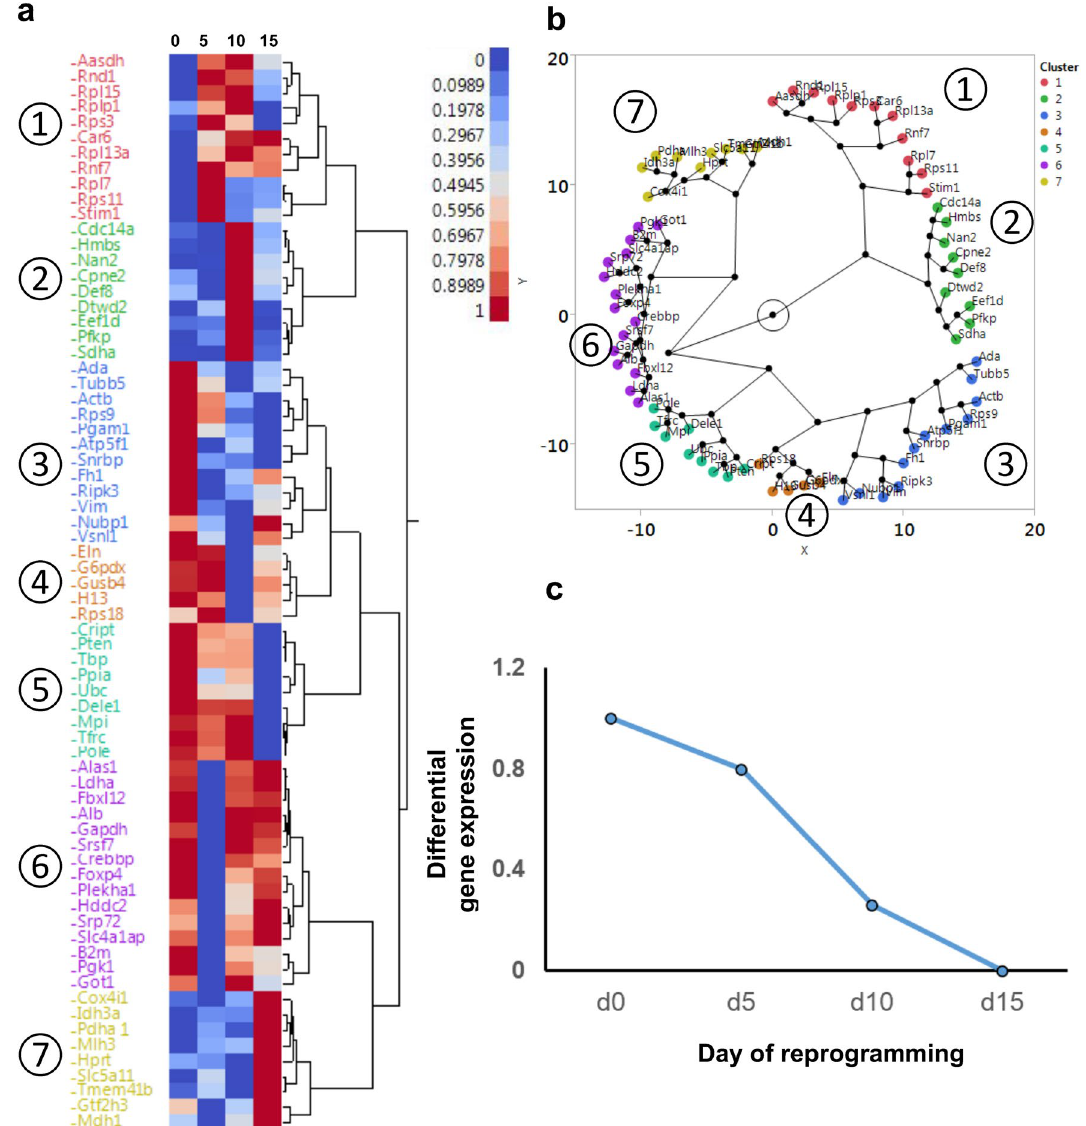
Figure 2. Expression change of 70 housekeeping genes throughout the iPS reprogramming process. (a) Clustering analysis of the dynamics of gene expression levels during reprogramming. Gene expression levels relative to Day 0 were considered and scaled from 0 to 1 for each gene. The color scale attributes red to a value of 1, indicating the highest gene expression during reprogramming. Four time points during the reprogramming are indicated over the heatmap (Days zero, five, ten and fifteen), and the gene names are shown on the left. JMP Version 11 software was used to create the figure (https ://www.jmp.com). (b) Alternative visualization of the clustering analysis of (a) using a constellation plot. Genes are grouped by their similarity of expression dynamics. Lengths of the lines represent the statistical distance between clusters. (c) Relative dynamic of Actb gene expression by comparison to Day 0 during